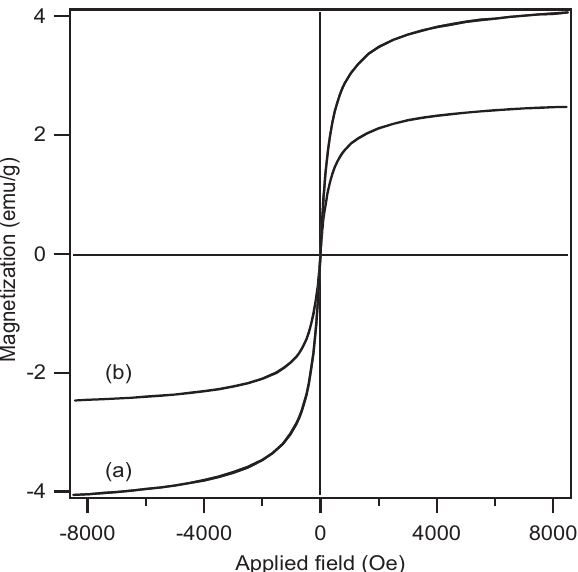
Figure 6: Magnetization curves of: (a) MNPs@MCM-41 and (b) MMNP.